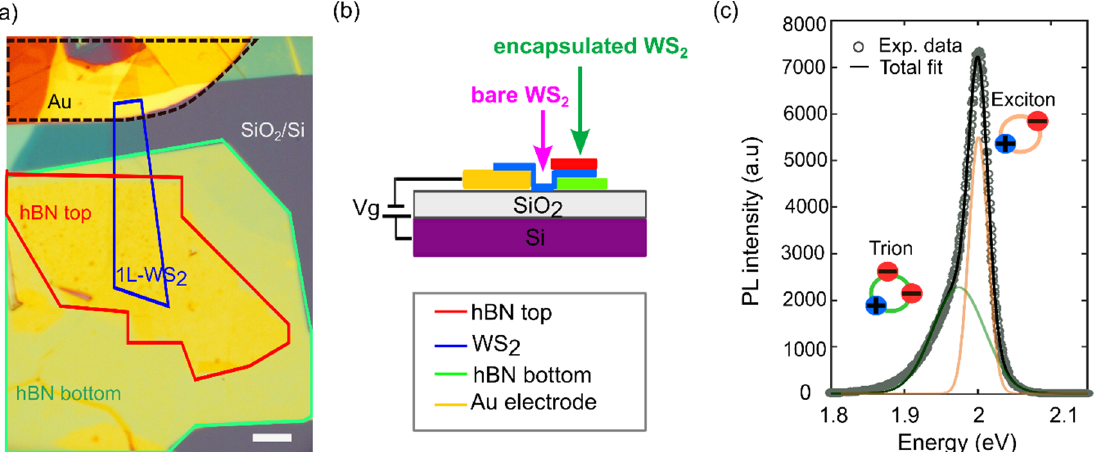
Figure 1. ( a ) Optical microscope images of the WS 2 -based device, and the scale bar corresponds to 20 µ m. ( b ) Schematics of the system highlights to show the two different WS 2 regions that can be experimentally accessed. ( c ) Photoluminescence spectrum of the hBN full encapsulated WS 2 monolayer fitted to two peaks corresponding to the emission from neutral excitons (orange curve) and trions (green curve).